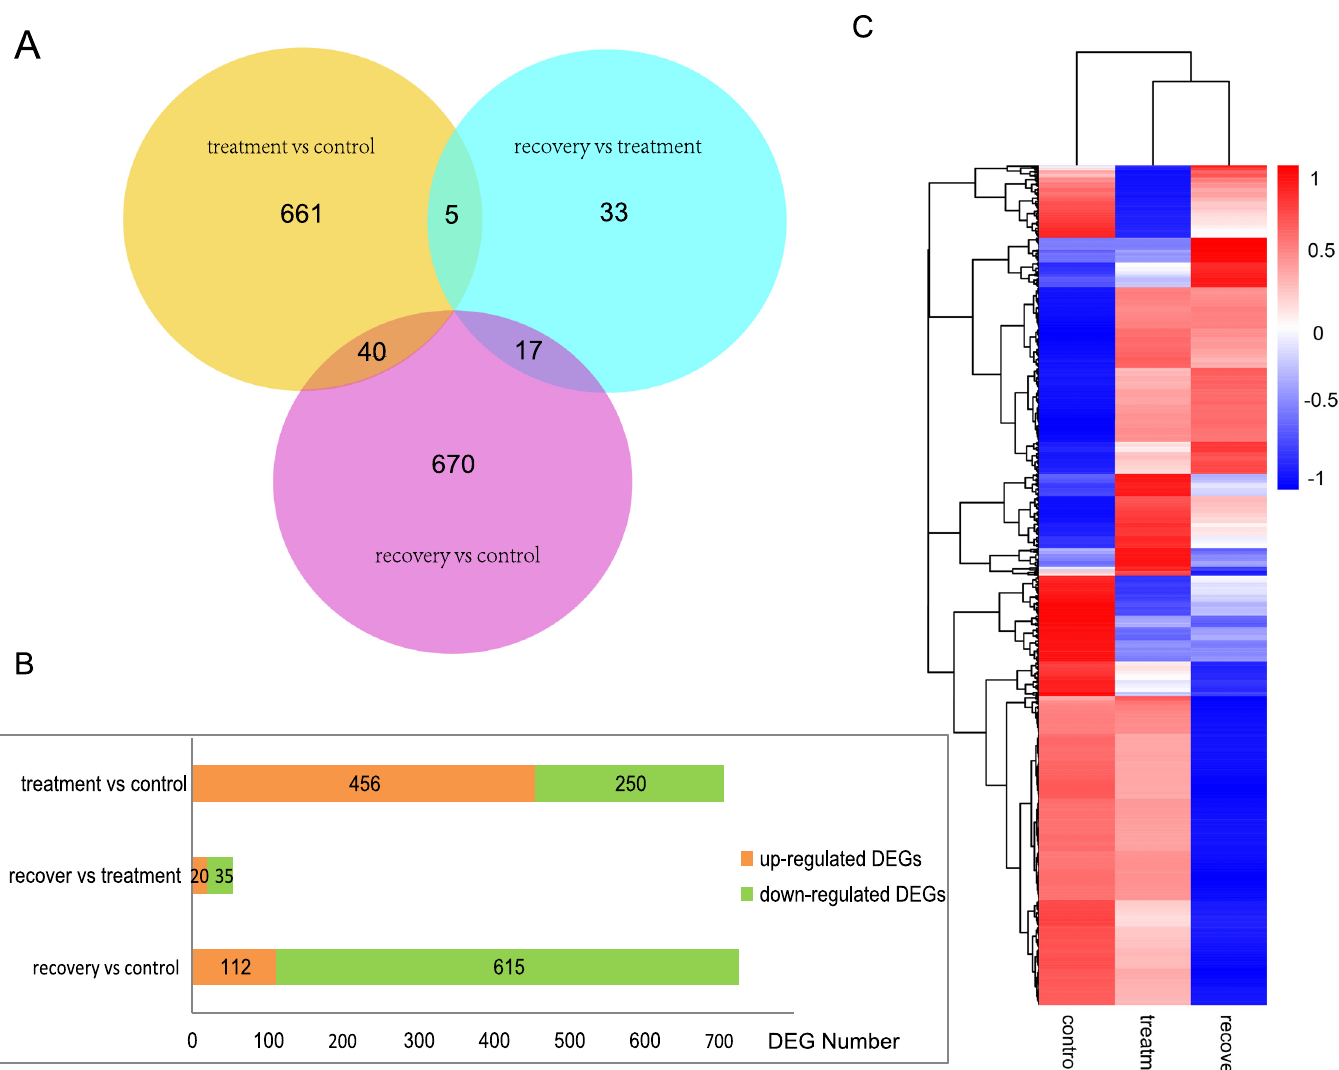
Fig 4. Differential gene expression analysis and clustering. (A)Venn diagram of DEGs. (B) Bar chart showing the number of DEGs detected between treatment combinations. (C) Differential gene clustering; red indicates high levels of gene expression and blue indicates low levels of expression. Colors indicate the range of log 10 (FPKM+1) values from large (red) to small